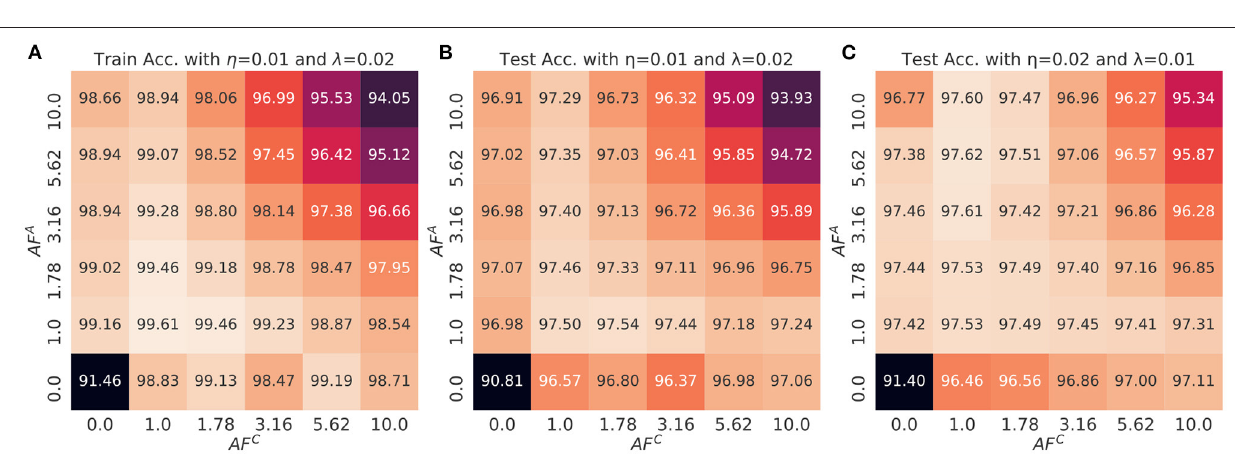
FIGURE 6 | Comparisons of approximated t ( k ) and W A of three cases in (A) Figure 5A and (B) Figure 5B . Raw data of t ( k ) and W A was averaged using exponential moving average and approximated with natural smoothing spline method.